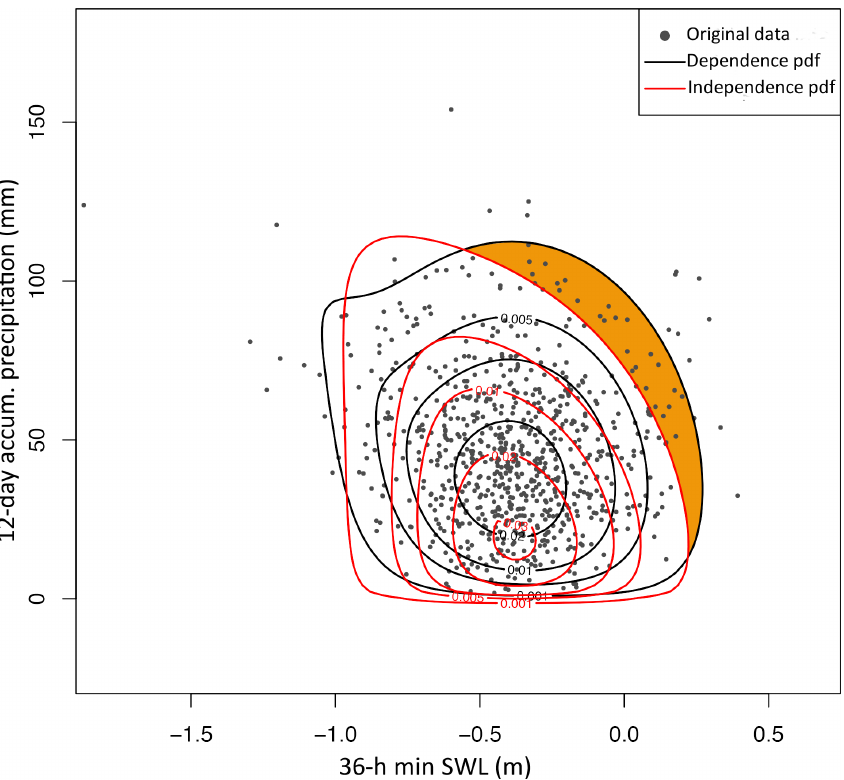
Figure 5. Scatter plot of S T and P 12d , acum and its joint PDF corresponding to original data (black) and shuffled data (red). Shaded 36h , min orange area highlights the increased probability of extreme S T and P 12d , acum for the original 36h , min